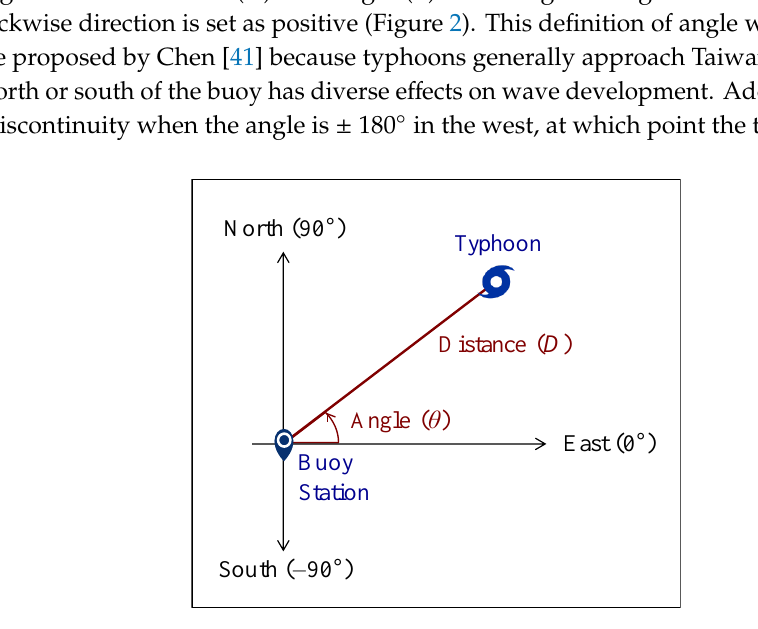
Figure 2. Definition of the distance and angle of a typhoon to buoy stations. Table 1. Typhoon events and wave data.